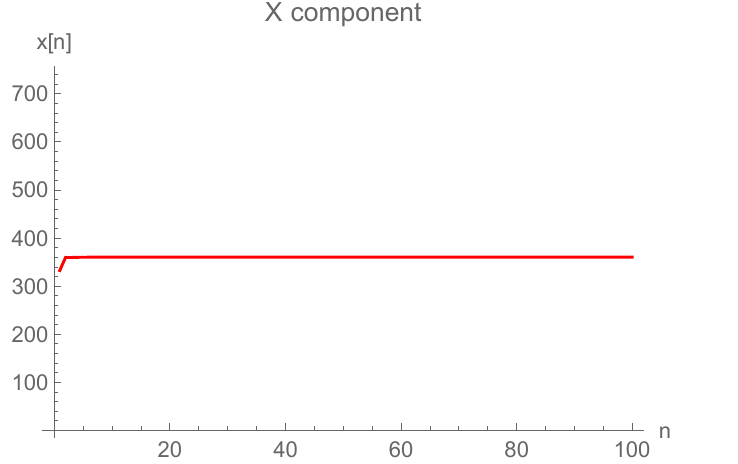
Figure 1. Graph of x n for α = 167, β = 0.01, γ = 0.03, δ = 0.4, ζ = 155, η = 0.05, µ = 0.05, ε =